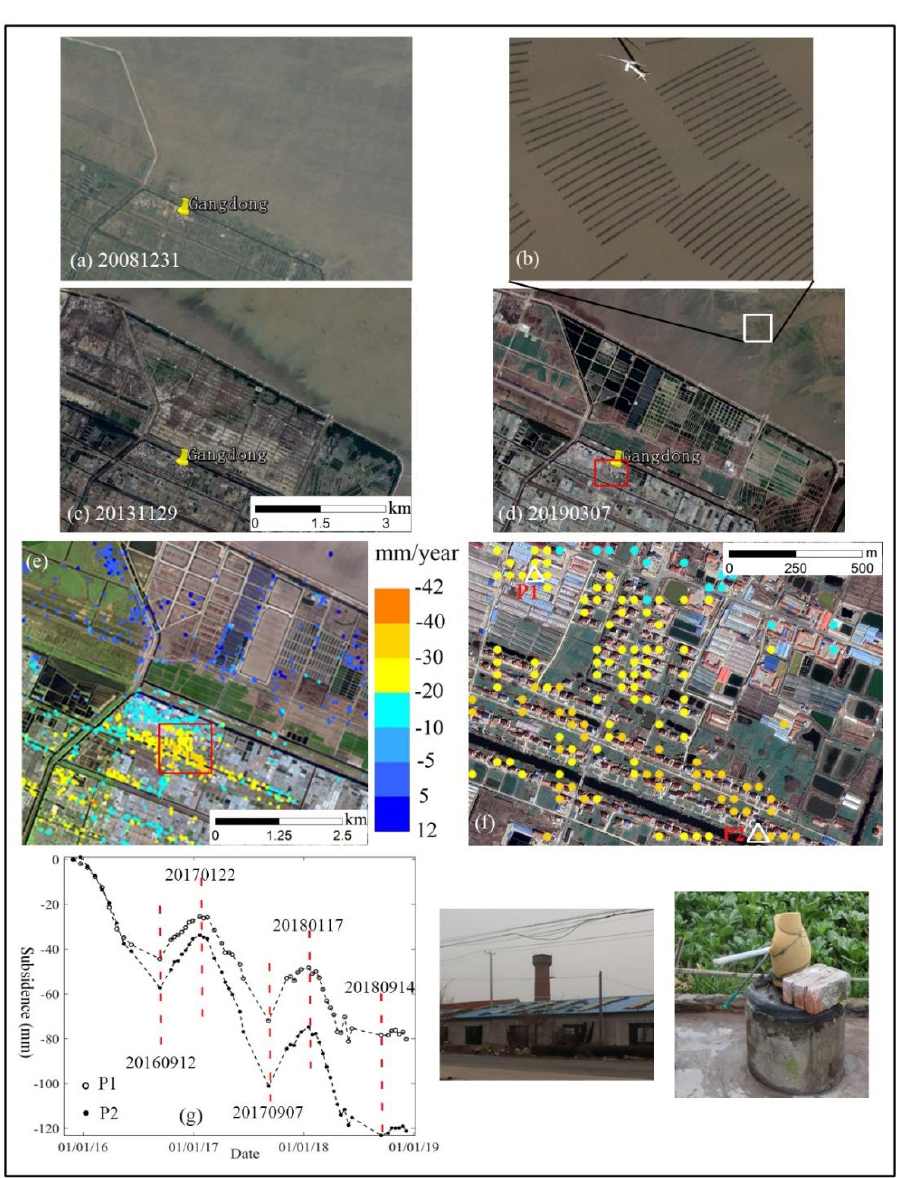
Figure 11. The enlarged view of Zone C in Figure 4 is shown in ( a ). The MSV within the white-line AOI in ( a ) is shown in ( b ). ( d – g ) are 4 historic images of the AOI which shows the land-use transition from farmland and muddy beach in 2003 to in- dustrial districts in 2017. The yellow-rectangle region in ( d ) corresponds to the image area of ( e – g ). The subsidence time series of two CPs marked by white-triangles in ( b ) is shown in ( c ). An on-site photo of FHPP is shown to the left of ( g ).